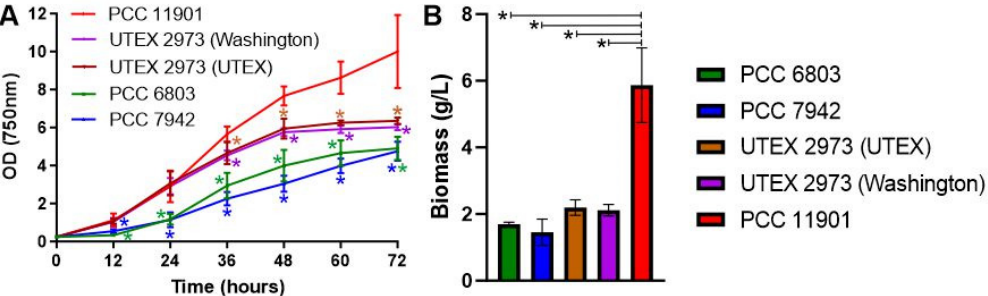
Figure 1. (A) Growth and (B) biomass accumulation of cyanobacterial species. Strains were cultured at 38 °C under 900 µmol photons m − 2 s − 1 continuous light intensity and with direct bubbling of air/5% CO 2 . Error bars indicate SD. Asterisks indicate significant differences between PCC 11901 and the other cyanobacterial species ( p < 0.05).